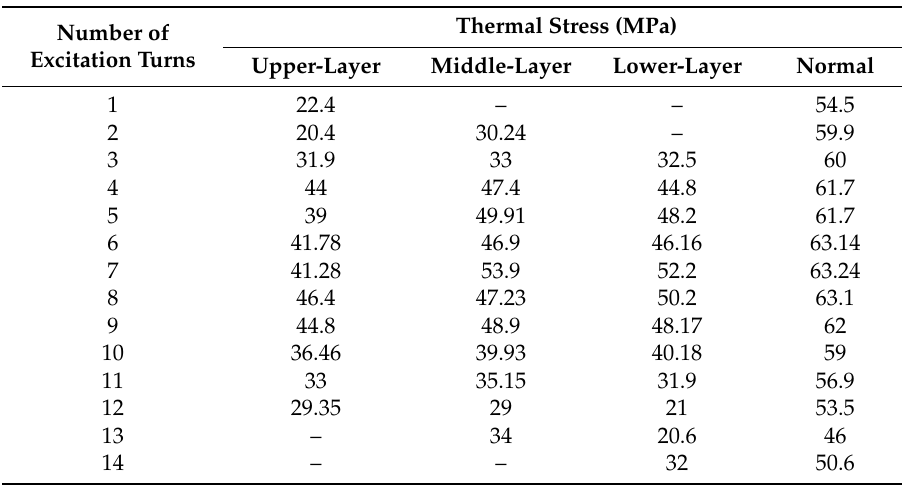
Figure 17. Thermal stress distribution of magnetic pole at different short circuit locations: ( a ) 2–4 turn short circuit; ( b ) 7–9 turn short circuit; and ( c ) 11–13 turn short circuit. Table 3. Three-turn short circuit thermal